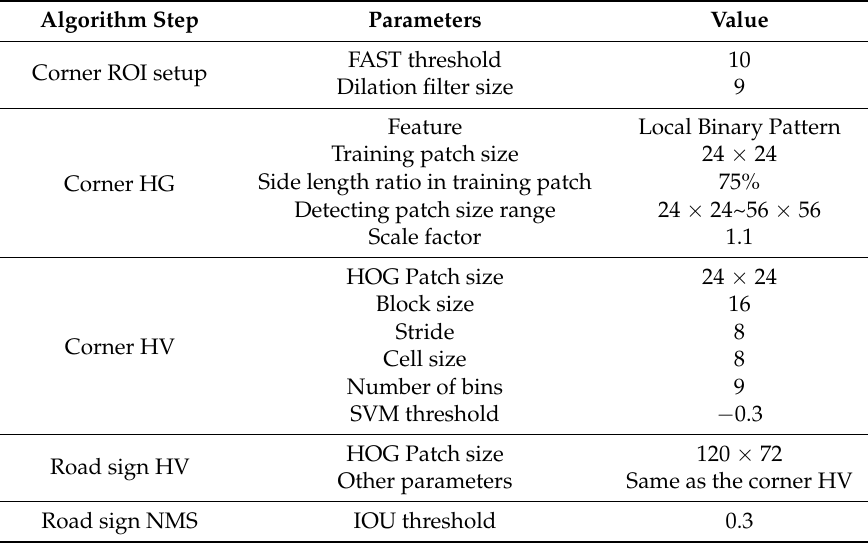
Table A2. Parameters for each algorithm step.